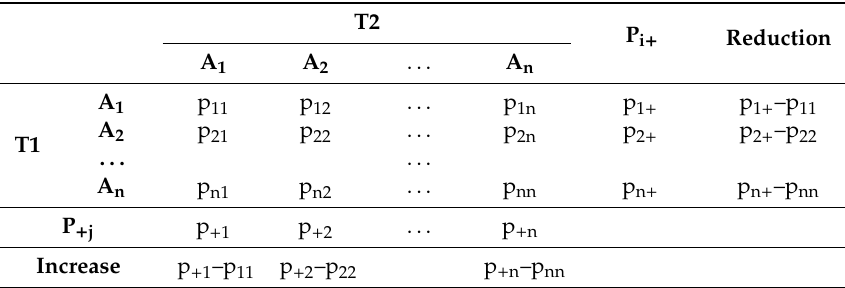
Table 1. Land use transition